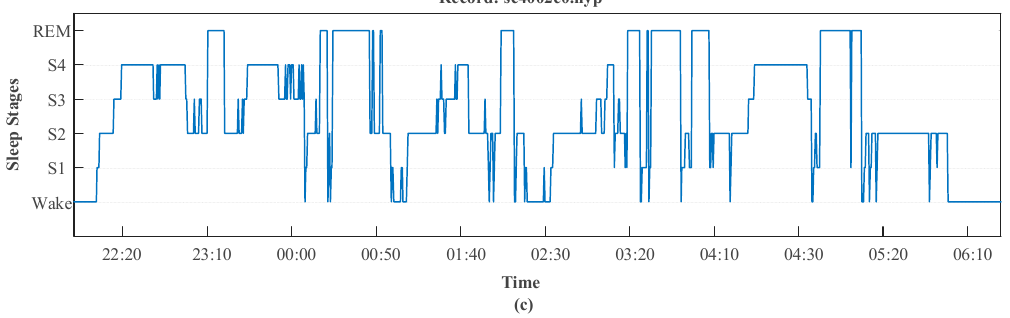
Figure 1. Sample polysomnogram (PSG) signals and scored hypnogram records obtained from the sleep-edf database: ( a ) wake stage, ( b ) rapid eye movement (REM) stage, and ( c ) hypnogram for sc40020 record between 22:20 and